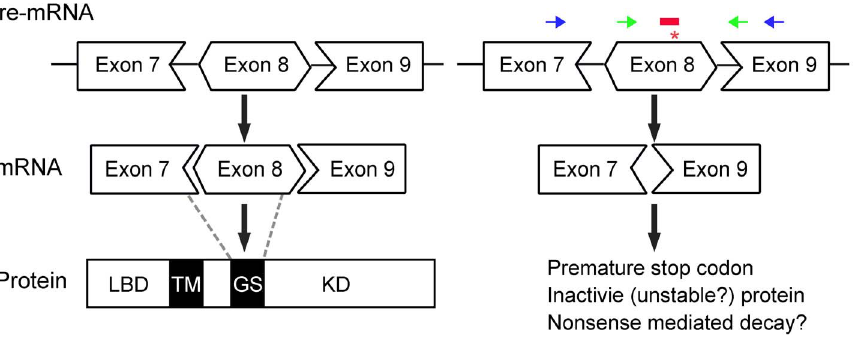
Figure 1. Schematic overview of ALK2 exon skipping. Left panel: The ALK2 protein structural domains include ligand binding domain (LBD), transmembrane domain (TM), GS domain (GS), and kinase domain (KD). The position of each exon relative to each domain is denoted by broken lines. Right panel: The FOP mutation hot spot (c.617G R A; R206H) is in exon 8 (*). ALK2 AON (red bars, the sequence covered the FOP mutation hot spot) hybridizes and hides exon 8 from the splicing machinery, resulting in skipping exon 8 upon mRNA splicing. This out-of-frame mutation will lead to non-sense mediated decay of Alk2 mRNA. qPCR primers to detect Alk2 expression are indicated by green arrows; The primers for detecting of skipped band are indicated by blue arrows. While we targeted exon 8 for exon skipping, we do not exclude that other AONs targeting other exons can be designed that also inhibit ALK2 expression.